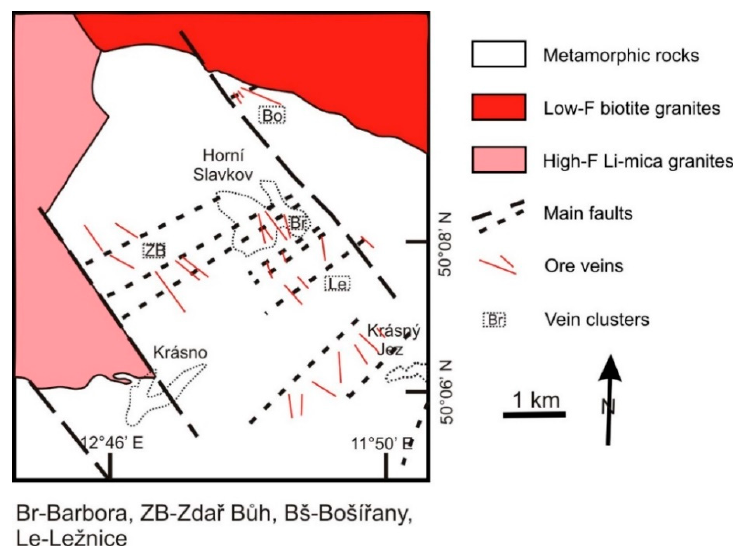
Figure 4. Schematic geological map of the Horní Slavkov uranium district (modified from Komínek et al. [24]).